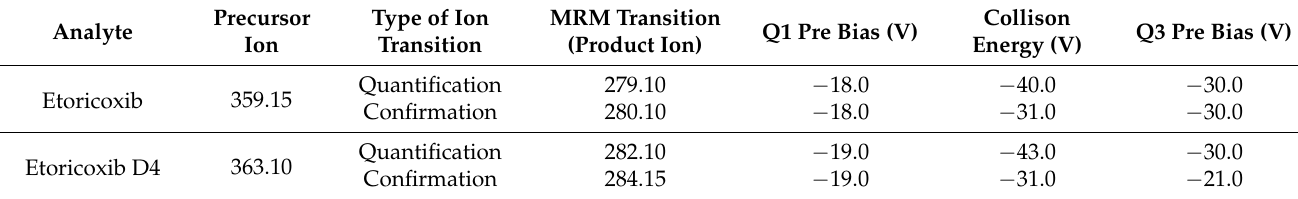
Table A1. Optimized MRM parameter of etoricoxib and etoricoxib